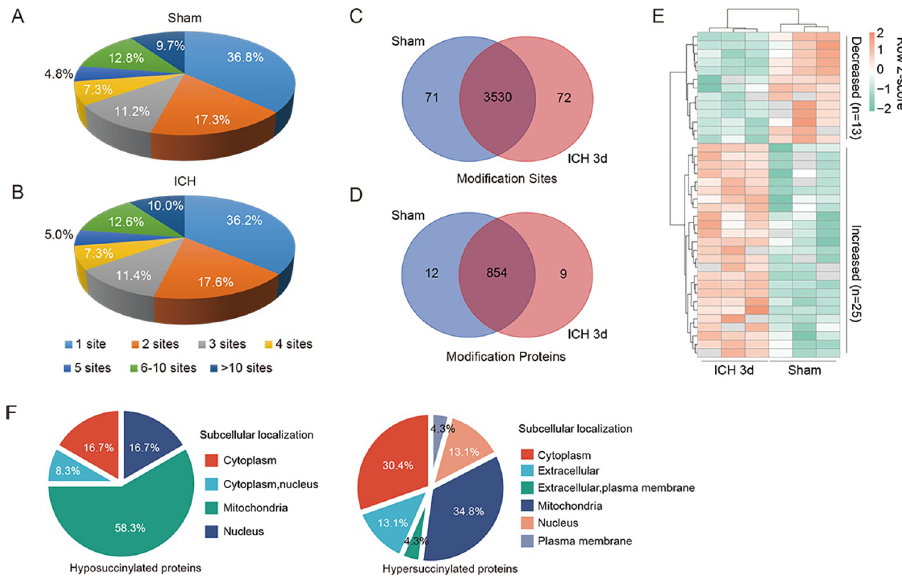
Fig 1. Quantitative succinylproteomics analysis of ICH and control brains. (A-B) Pie charts showing the proportions of singly and multiple succinylated proteins with the indicated number of succinylated sites per protein in control (sham) (A) and ICH (B) brains in vivo. (C-D) Venn diagram comparing succinylated sites (C) and proteins (D) between ICH and control brains. (E) The heat map shows the differential succinylated sites in ICH and control brains. (F) Subcellular localization of hyposuccinylated (right) or hypersuccinylated (left) proteins in ICH and control brains.